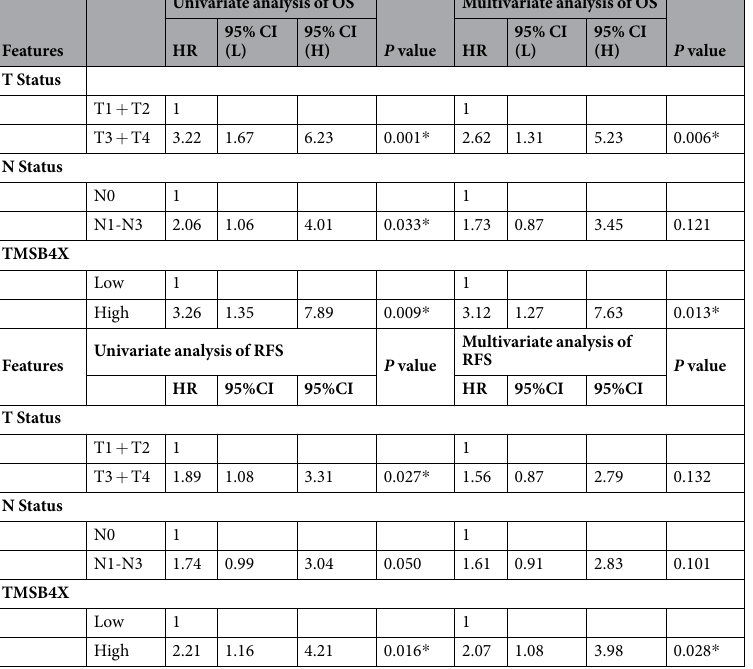
Table 3. Univariate/Multivariate Cox proportional hazards regression analyses on OS and RFS time of TMSB4X gene expression in HNSCC. * P < 0.05 (Cox proportional hazards regression analyses). The 95% confidence interval (CI) for the hazard ratio (HR) in overall survival (OS) or recurrence-free survival